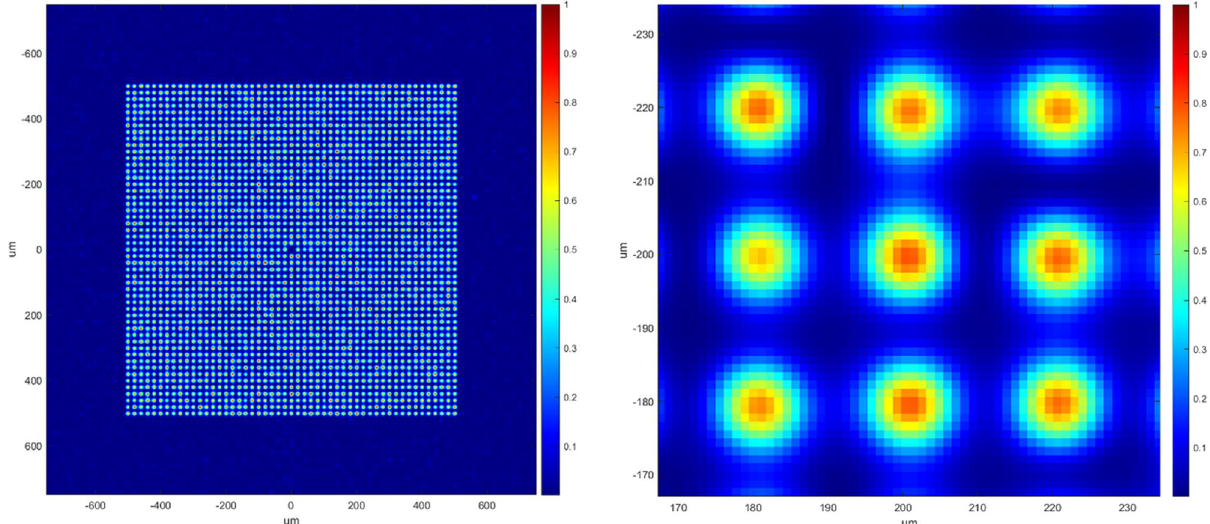
Figure 1. Simulation of the DOE splitter output at EFL = 100 mm, input beam 8 mm, wavelength 1030 nm (left: full field, right: zoom on 3 × 3 points). Slight Uniformity imperfections due to interference between neighbouring orders.